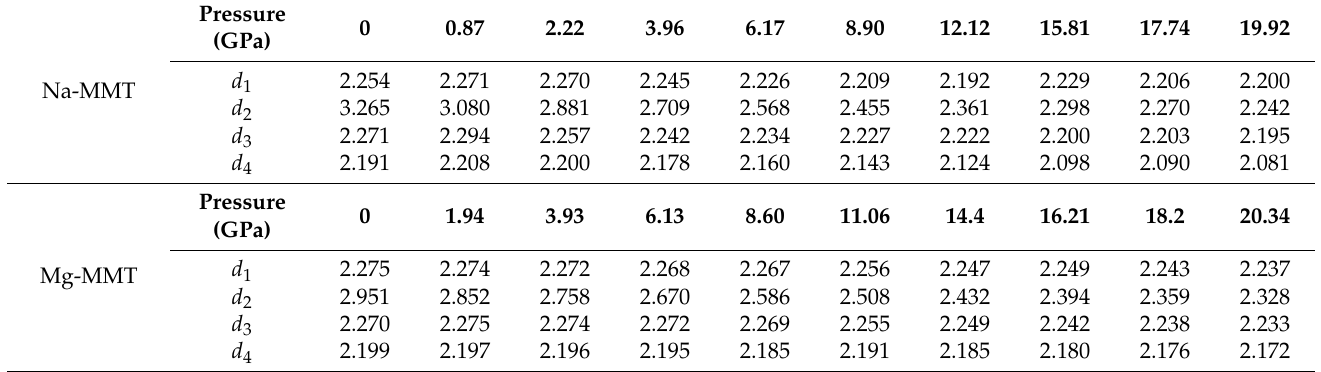
Table 10. The average layer thickness and interlayer thickness (Å) of Na-MMT and Mg-MMT under pressure.